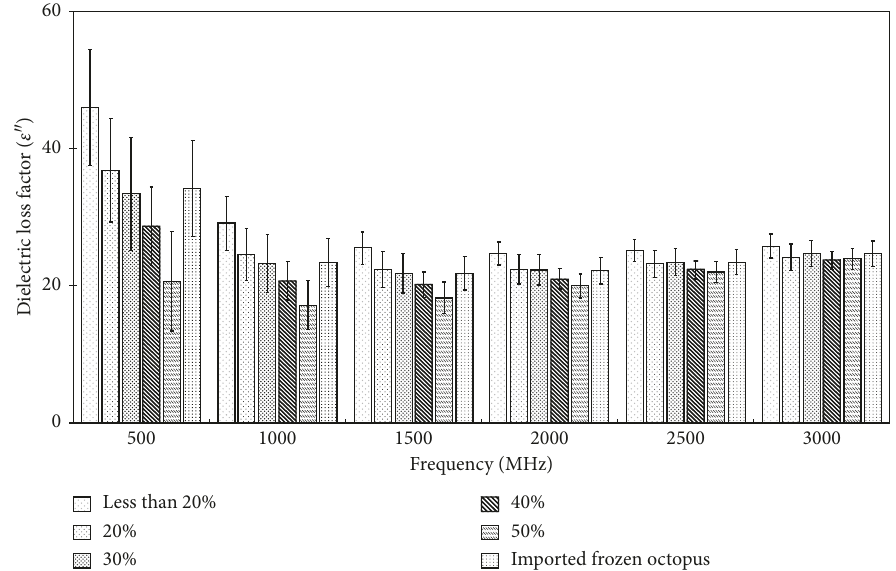
Figure 4: Dielectric loss factor adulterated and imported frozen octopuses measured at the trunk part after thawing.